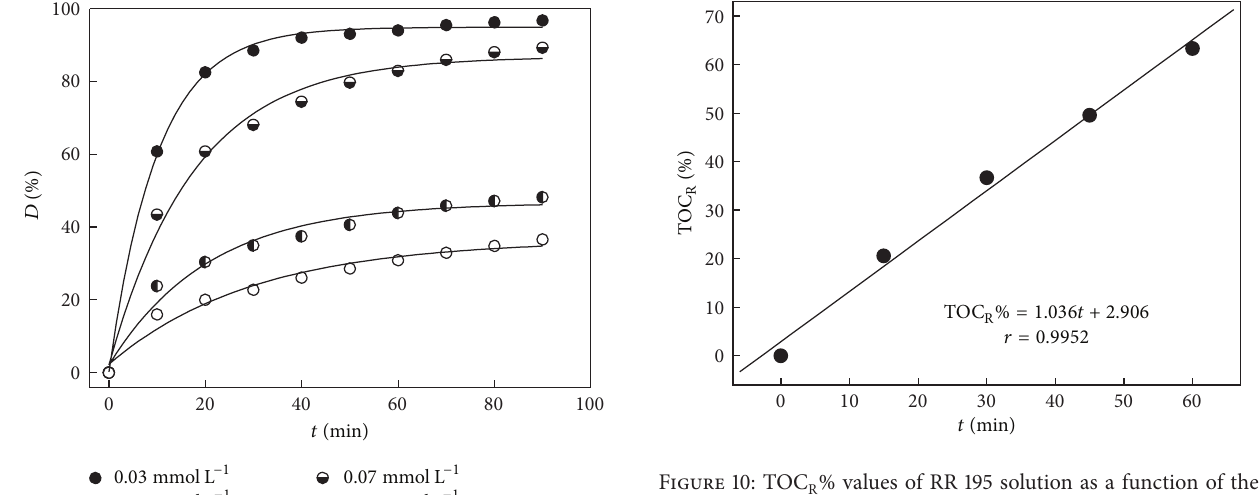
Figure 10: TOC % values of RR 195 solution as a function of the R reaction = Fe